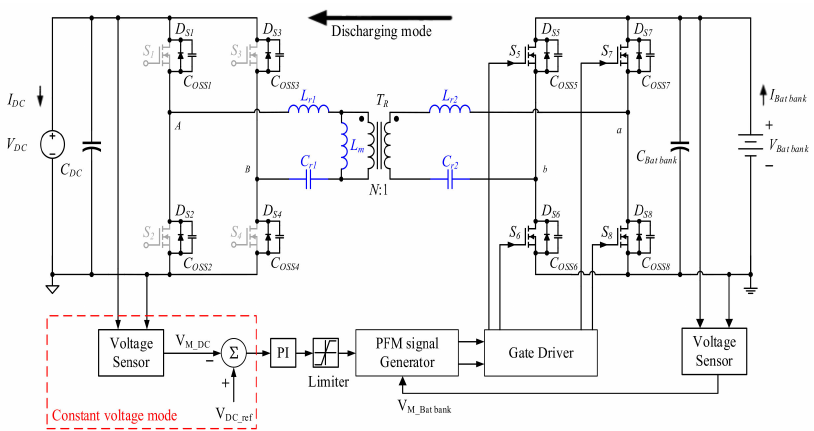
Figure 14. Control framework of the proposed CL 3 C full-bridge resonant converter for the discharg- ing